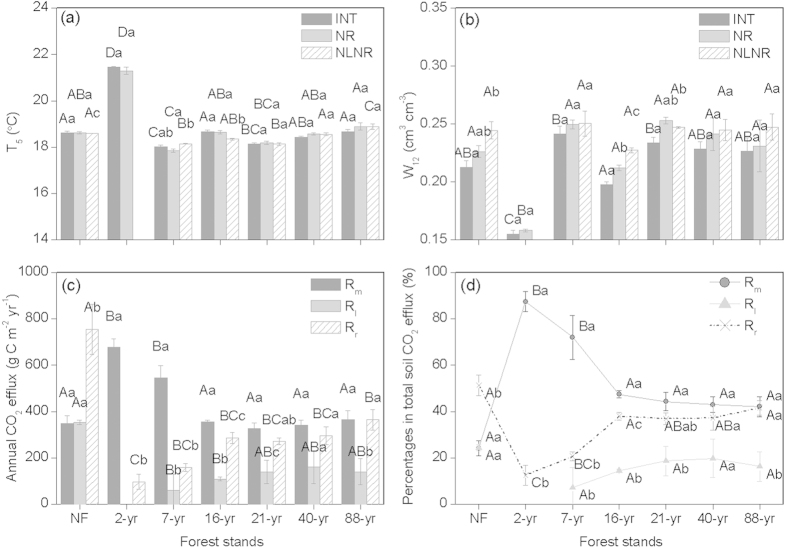
Annual mean soil environmental factors and annual component fluxes of soil respiration across the Chinese fir chronosequence in southern China (from 2- to 88-year-old, native forest (NF) as the control).(a) Soil temperature at 5 cm depth (T5); (b) soil moisture at the 0-12 cm depth (W12) for the intact (INT), root exclusion (NR), and litter plus root exclusion (NLNR) treatments; and (c) annual CO2 effluxes from decomposition of mineral SOC (Rm), litter decomposition (Rl) and root and rhizosphere respiration (Rr), and (d) their contributions to total annual soil CO2 effluxes. The error bars represent standard errors [n = 3 (plots)]. Data with the same upper-case letters are not significantly different among stands and those with the same lower-case letters are not significantly different among treatments (p > 0.05).